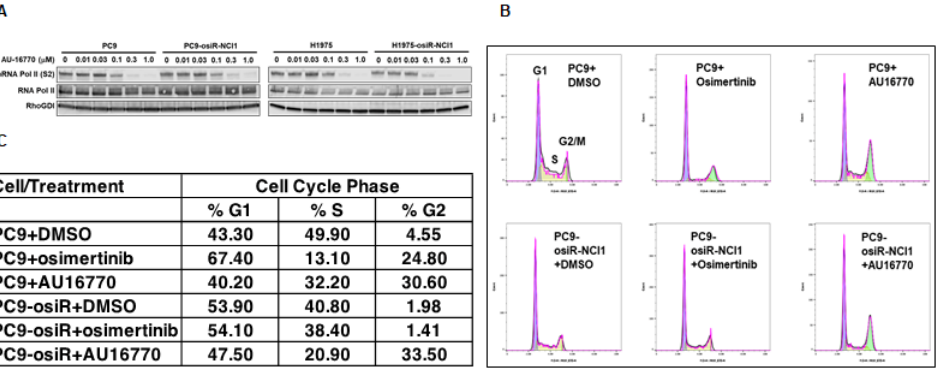
Figure 5. Cell-cycle analysis reveals AU-16770 treatment of PC9 and PC9-osiR-NCI1 cells causes G2 arrest. ( A ) PC9 and PC9-osiR-NCI1cells were treated with 0, 0.01, 0.03, 0.2, 0.3, and 1.0 µM AU-16770 for 3 h. Cell lysates were immunoblotted with RNA Pol II antibodies and Ser2 or-Ser5 phospho-specific RNA Pol II antibodies to determine the effective concentration of AU-16770 required to inhibit RNA Pol II-Ser2 phosphorylation, a marker of CDK12 activity. RhoGDI was used as a loading control. ( B ) Cell-cycle analysis of PC9 and PC9-osiR-NCI1 cells by flow cytometry. Cells were treated with DMSO (control), 50 nM osimertinib, or 100 nM AU-16770 and stained with propidium iodide. ( C ) Relative quantification of the proportion of cells in G1, S, and G2 phases shows that AU-16770, but not osimertinib treatment, causes a significant proportion of PC9-osiR-NCI1 cells to accumulate in